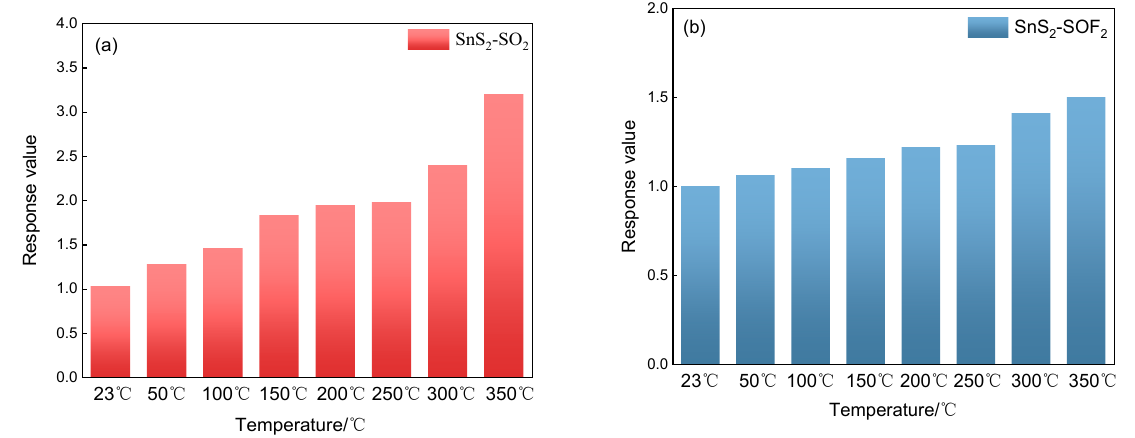
Figure 4. Temperature response characteristics of sensor to two SF 6 decomposition components: ( a ) 150 ppm SO 2; ( b ) 50 ppm SOF 2 .